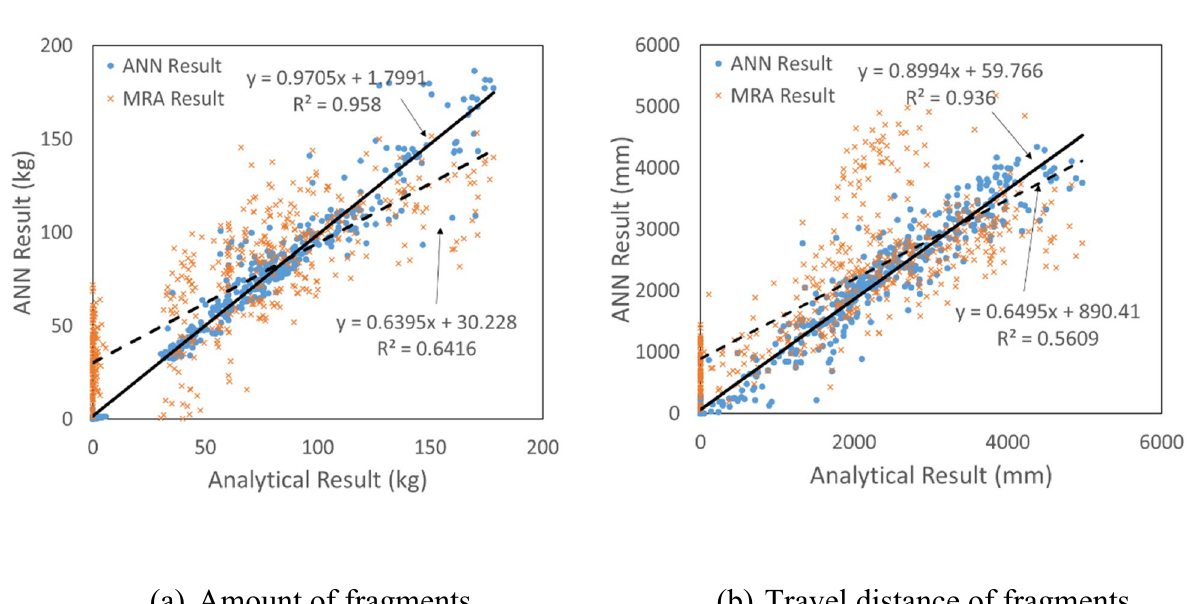
Figure 11. Comparison of the MRA and